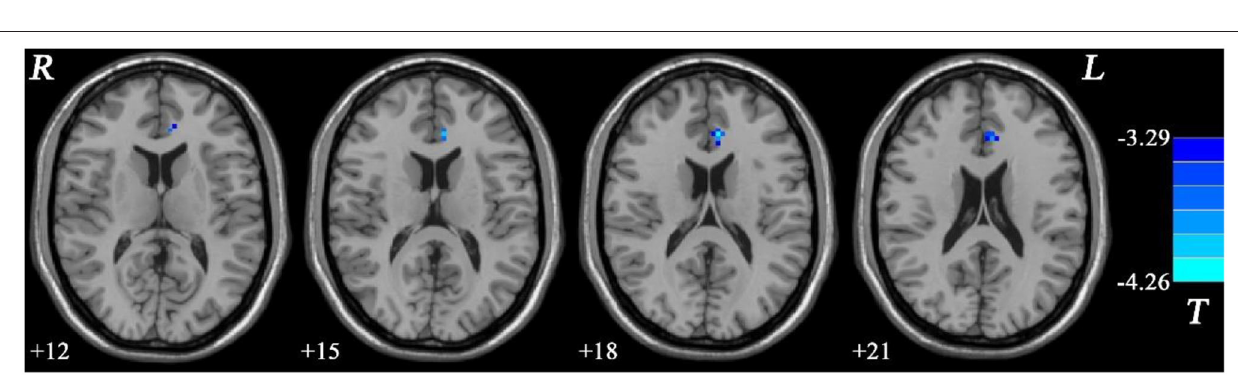
FIGURE 4 | Fractional amplitude of low-frequency fluctuation (fALFF) differences between melancholic major depressive disorder (MDD) and non-melancholic major depressive disorder (MDD). Blue represents decreased regional spontaneous activity in the melancholic